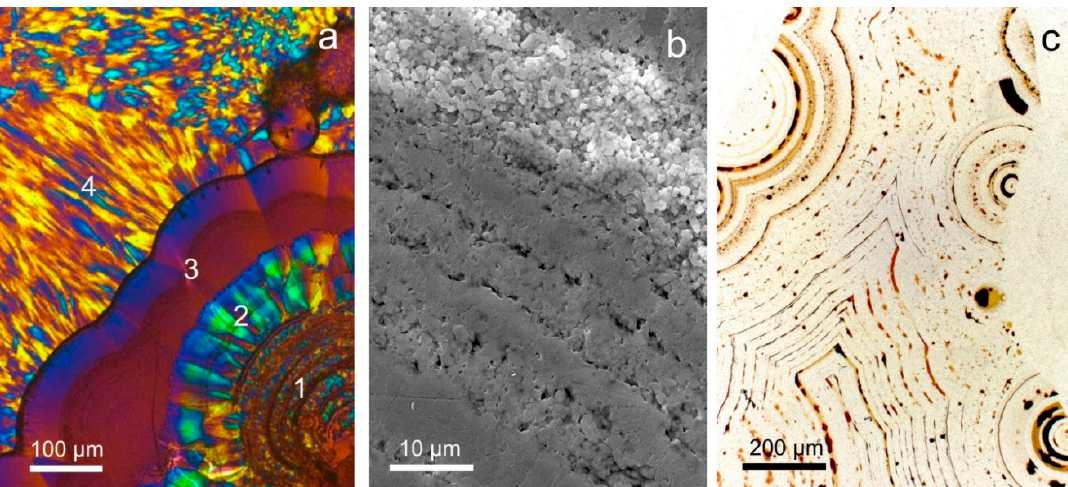
Figure 10. ( a ) Micrograph in transmitted light (crossed polars, λ -compensator) of an agate from the Whale Bay, Iceland showing a sequence of microcrystalline, granular quartz (1) quartzine (2) opal-C (3) fibrous chalcedony (4); ( b ) SEM micrograph of an agate from St. Egidien (Saxony, Germany); the high magnification reveals significant variations in crystal size and porosity in the different chalcedony layers; ( c ) transmitted light micrograph of an agate from Wiederau (Saxony, Germany); fine-dispersed Fe-oxides / -hydroxides are aligned along the micro-banding and cause the visible color banding.